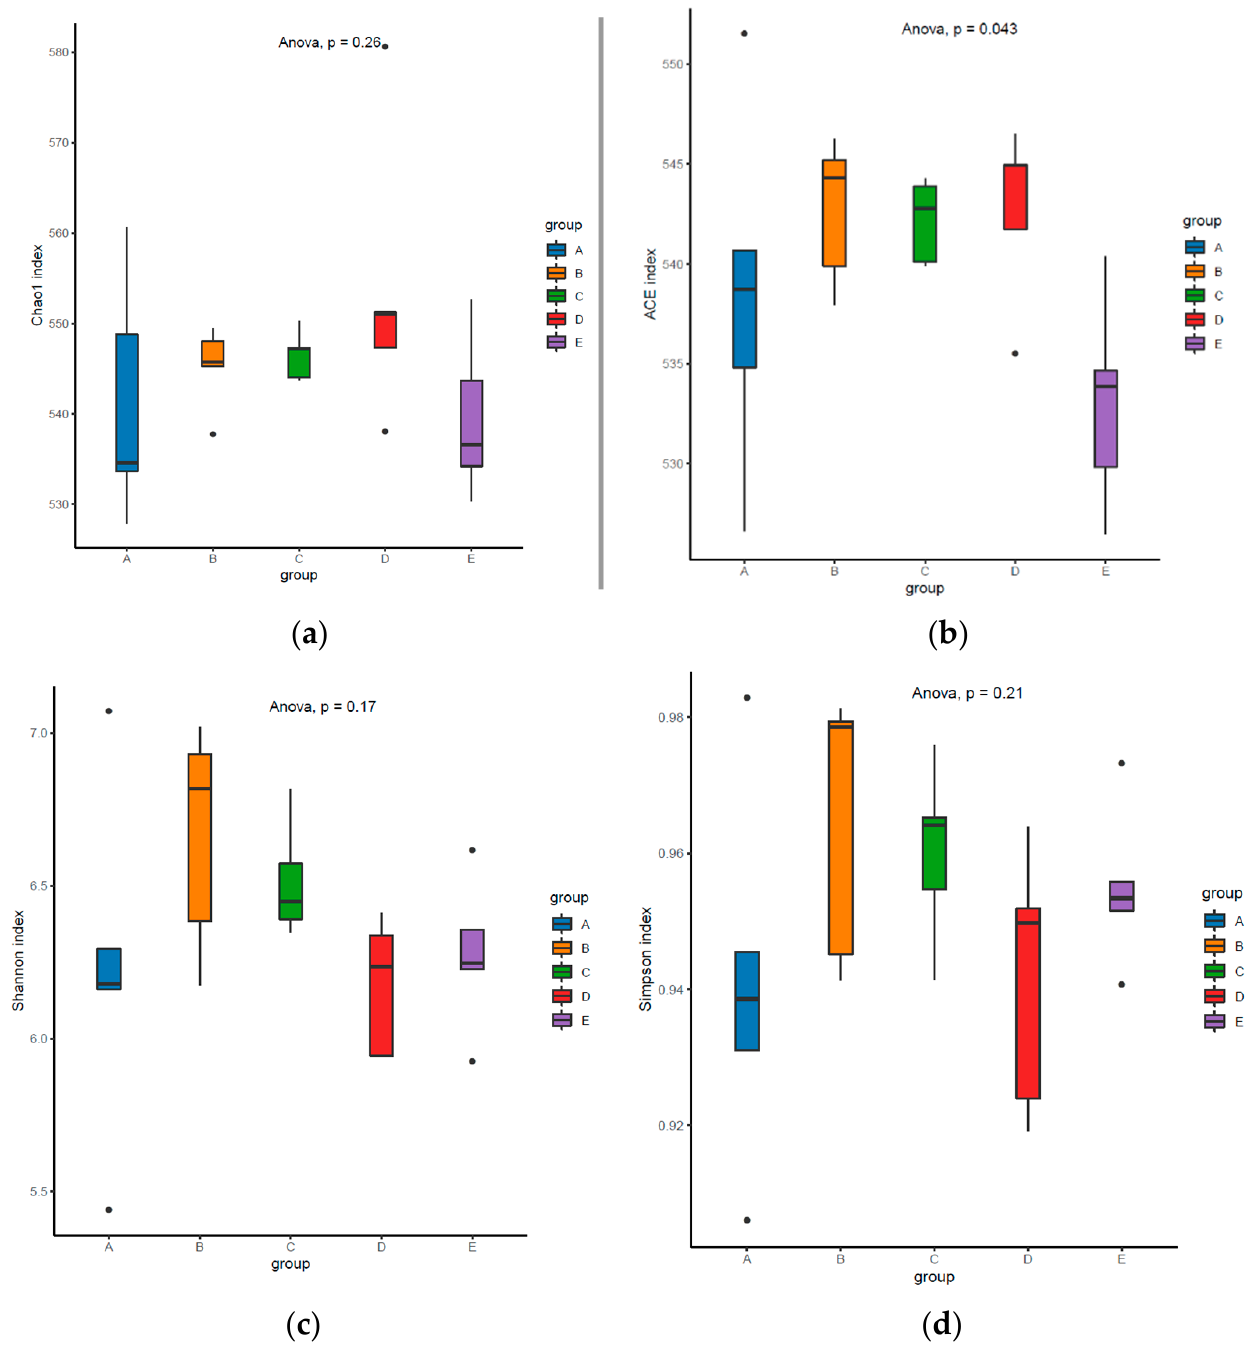
Figure 1. Alpha diversity including Chao1 ( a ), Ace ( b ), Shannon ( c ), and Simpson ( d ) of the colon communities of individual pigs after feeding control diet (A, CON), low protein diet (B, LP), LP + sodium dichloroacetate diet (C, LP + DCA), LP + sodium dichloroacetate diet (D, LP + GLUC), and LP + DCA + GLUC diet (E), respectively. n = 5.